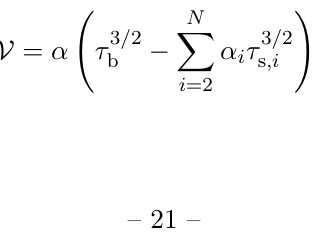
Figure 8 . Results from a lattice simulation of the KKLT model with W per dimension. The (cid:12)gure shows the three dimensional energy density distribution. The green surfaces correspond to regions with six times the average energy density h (cid:26) i while the blue surfaces indicate (cid:26)= h (cid:26) i = 12. The energy density distribution is shown at four di(cid:11)erent moments in time denoted by the corresponding scale